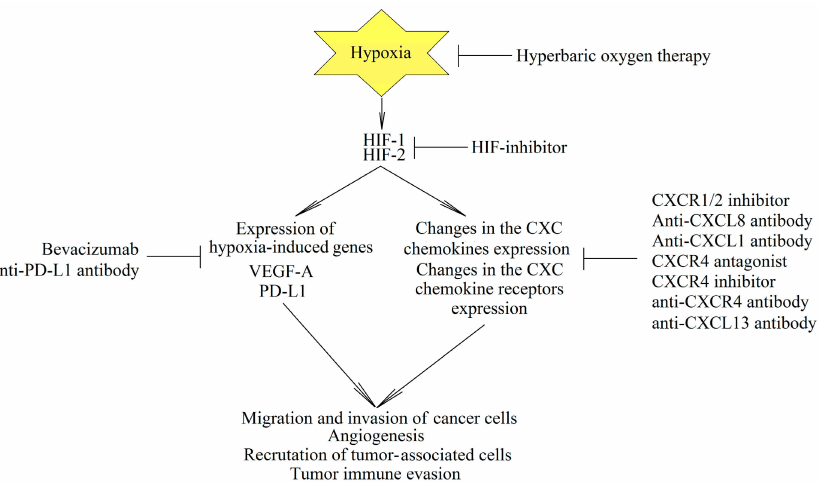
Figure 5. Hypoxia as an essential element of cancer mechanisms and as a therapeutic target. Hypoxia leads to an increase in the expression of genes essential for tumor progression, especially CXC chemokines, CXC chemokine receptors, and other genes encoding VEGF-A and programmed death- ligand 1 (PD-L1). As hypoxia occurs mainly in the tumor, cancer-specific therapy can be developed by using hyperbaric oxygen therapy and HIF inhibitors. Researchers are also investigating the potential of inactivating specific proteins whose expression is increased by